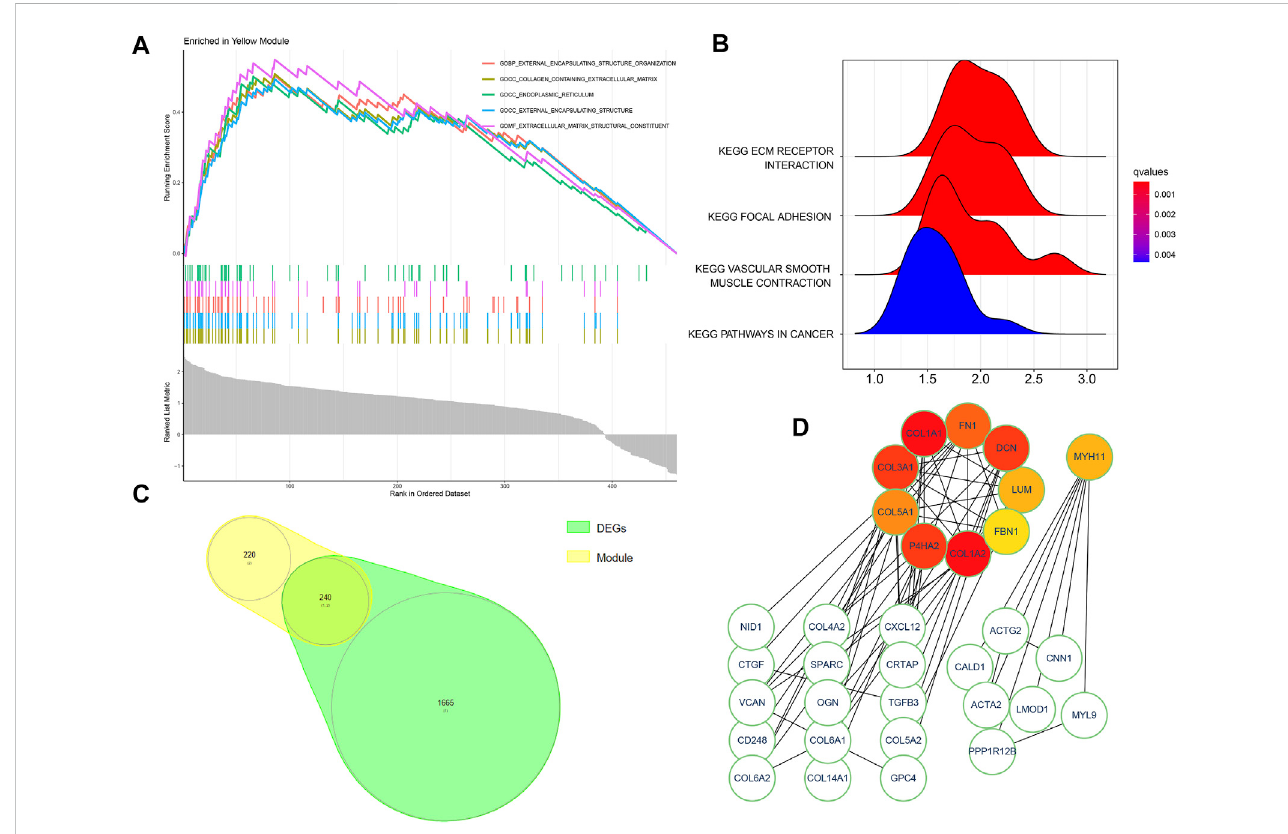
FIGURE 4 (A,B) GSEA analysis for the yellow module genes exported from the WGCNA method. (C) Intersected genes of the yellow module and DEGs. (D) Ten colored modules indicate hub genes and two regulatory network clusters of intersected